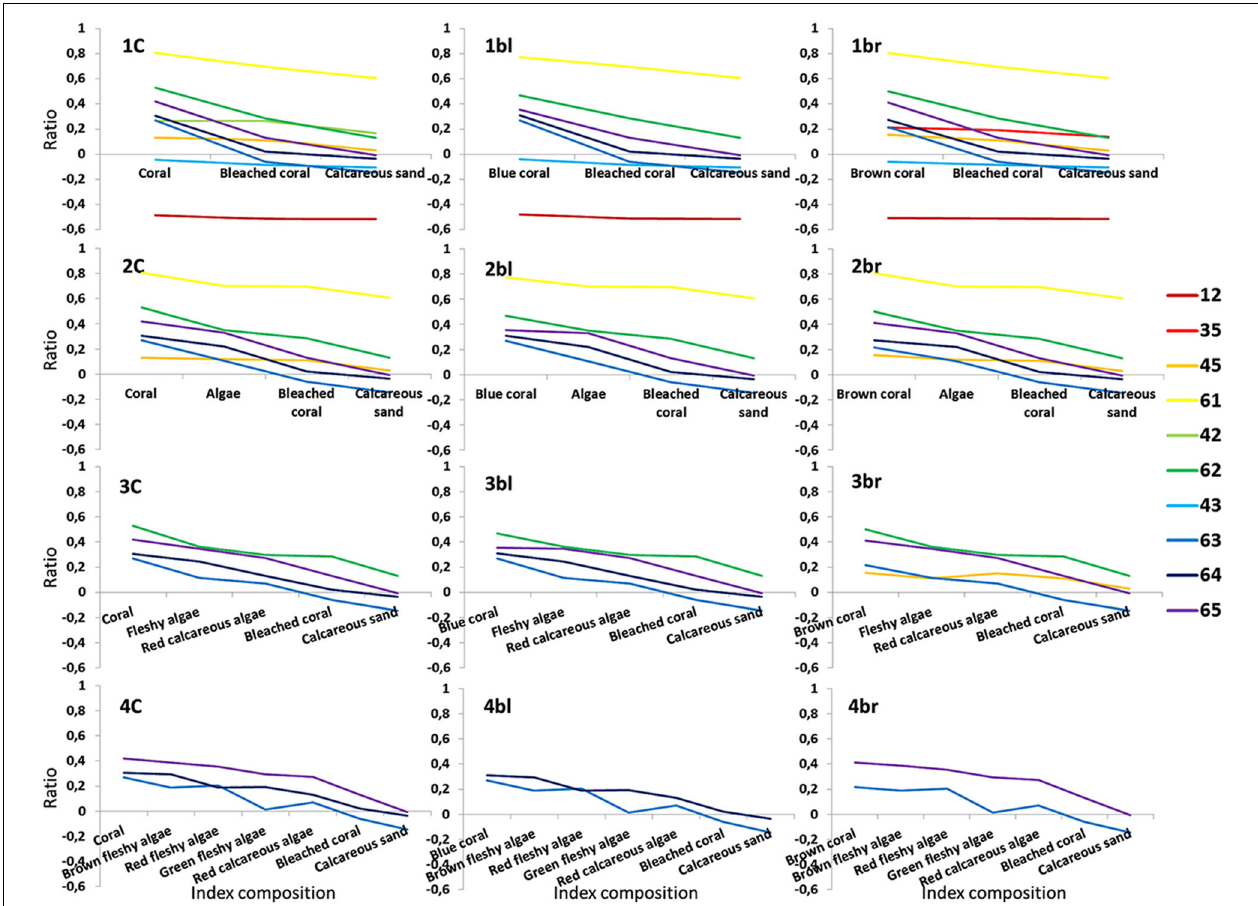
FIGURE 7 | Line plots of the 10 Normalized Difference Ratio ( NDR ) types in respect to the 12 coral reef indices. Figures 1 – 6 are respectively related to “coastal,” blue, green, yellow, red, “red edge.” Coded names 1C, 1bl, 1br mean Coral, Blue coral, Brown coral,